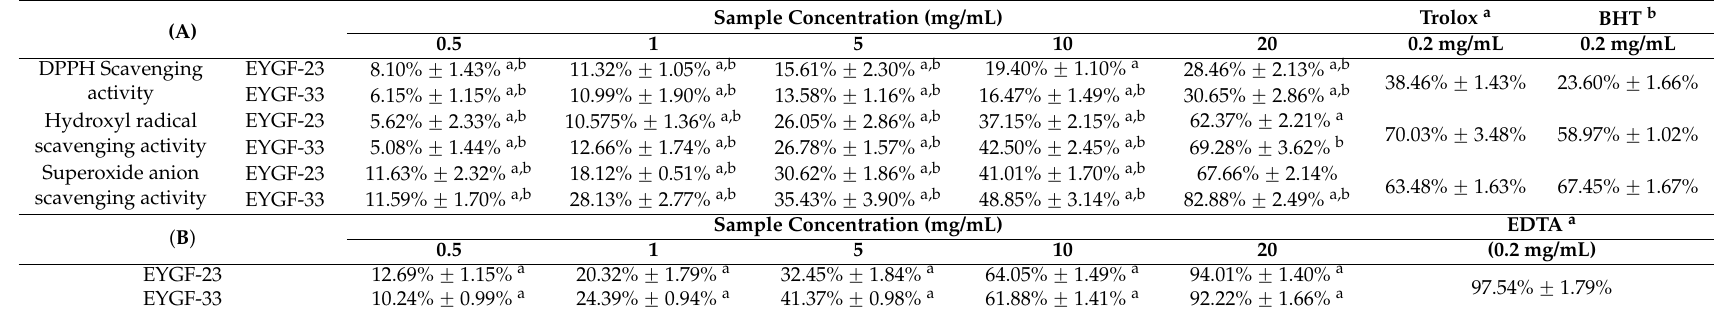
Table 1. Antioxidant activities of EYGF-23 and EYGF-33. The activity was measured over a concentration range of 0.5 to 20 mg/mL for each isolated fraction ( A ) represents the activities measured using DPPH radical scavenging, HRSA and superoxide anion scavenging activity assays. The activity of both fractions was compared to trolox as a natural antioxidant standard and BHT as a synthetic antioxidant standard (both 0.2 mg/mL); ( B ) represents the chelation activity measured using the Fe 2+ chelating activity assay, the activity was compared to EDTA (0.2 mg/mL). Data correspond to the mean ˘ SD of three independent experiments. ANOVA was performed in Graphpad Prism version 6.0, followed by Dunnett’s multiple comparisons test. Values with subscript a indicate significant differences with trolox, and subscript b indicate significant differences with BHT p <